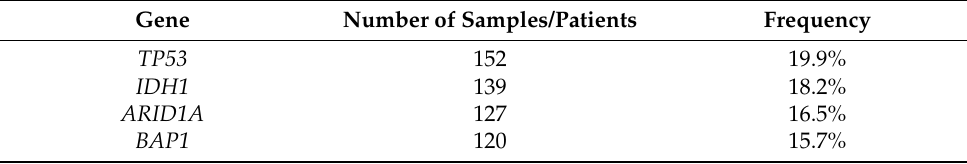
Table 1. The most commonly mutated genes reported across 772 profiled